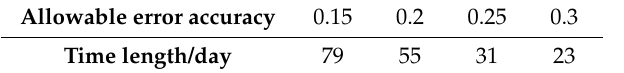
Table 2. Selection scheme of data time length.